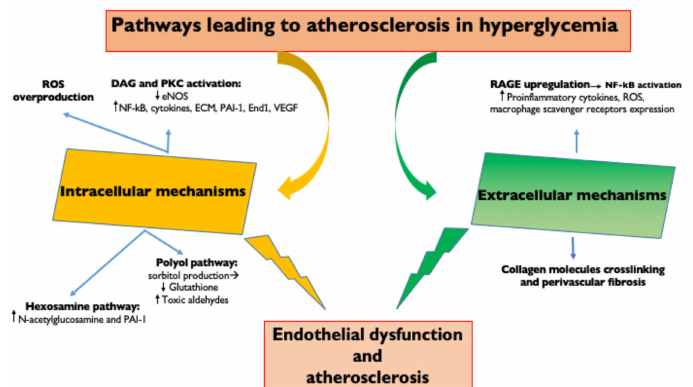
Figure 1. Pathways leading to atherosclerosis in hyperglycemia. Intracellular and extracellular molecular mechanisms underlying hyperglycemia-induced endothelial dysfunction. ROS, Reactive oxygen species; DAG, diacylglycerol; PKC, Protein kinase C; eNOS, endothelial Nitric Oxide Synthase; NFkB, Nuclear Factor κ B; ECM, extracellular matrix; PAI—1, Plasminogen activator inhibitor-1; End1, endothelin 1; VEGF, Vascular endothelial growth factor; AGE, Advanced glycation end products; and RAGE, receptor for advanced glycation end